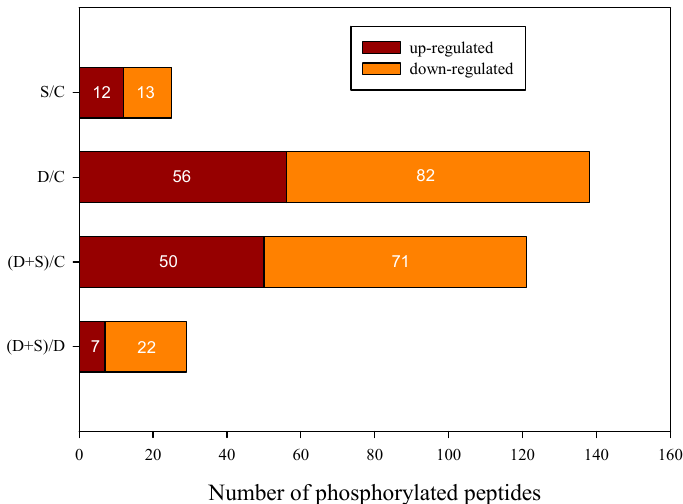
Figure 3. Upregulated and downregulated significant phosphorylated peptides among four groups. For a detailed description of treatment conditions, please refer to the legend of Figure 1.